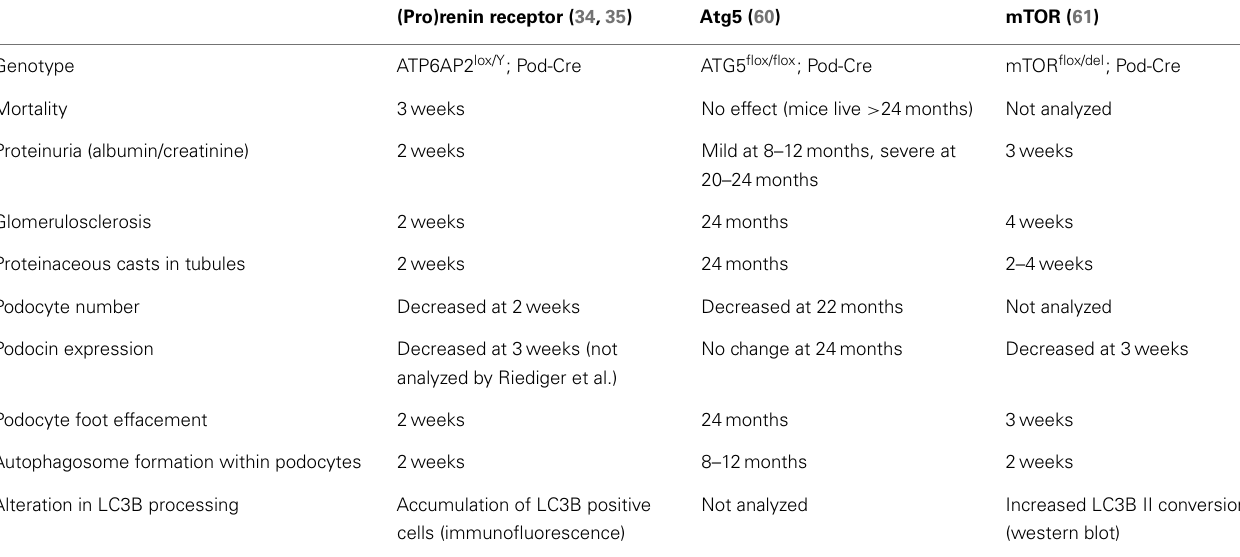
Table 1 | Comparison of the time of onset of various parameters in PRR and autophagy-related podocyte-specific knockout mouse